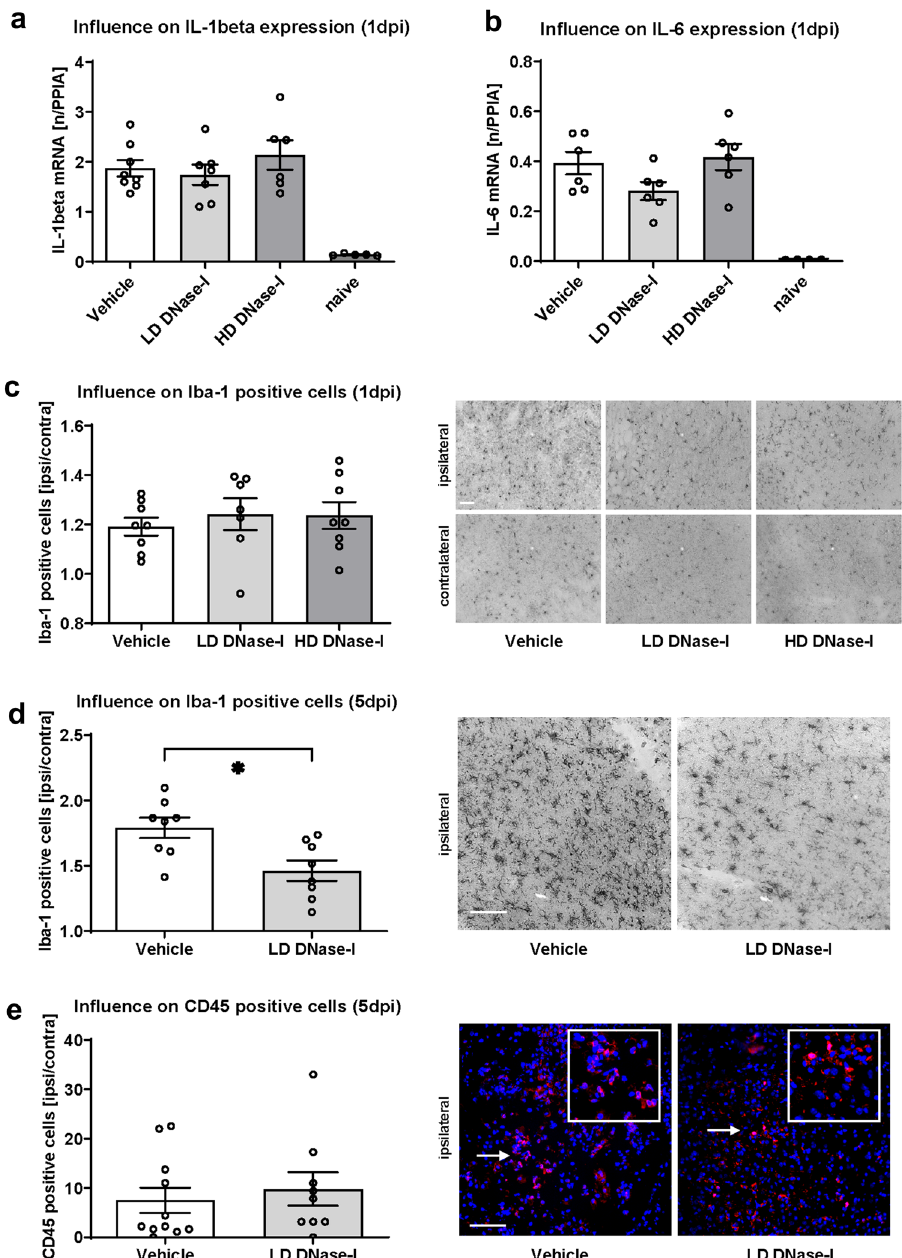
Figure 3. Effects of DNase-I injection on inflammation markers after traumatic brain injury. ( a , b ) Effects of DNase-I on pro-inflammatory marker genes IL-1 β ( a ) and IL-6 ( b ) as measured by qPCR at 24-h post- controlled-cortical-impact (CCI, 1 dpi). Scale bars 50 µm each in all images 4C, 4D and 4E. ( c ) Effects of DNase-I on the number of activated perilesional microglia as evidenced by Iba-1 immunostaining. DNase-I did not substantially reduce neuroinflammation at 1 dpi (n = 10 mice/group). ( d ) The pericontusional increase in Iba1 + cells was significant lower in LD DNase-I treated mice than vehicle-treated mice at 120 h post-CCI (5 dpi) but ( e ) treatment did not alter the number of CD45 + cells (n = 12 mice/group). A significance level p < 0.05 is marked with *, p < 0.01 with **, and p < 0.001 with ***. All data are presented as mean ± SEM; p values are adjusted for multiple comparisons by Sidak